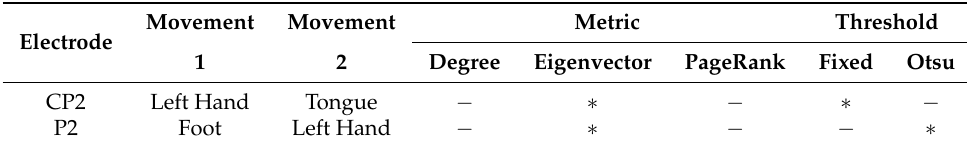
Table 4. p -values < 0.05 for the post hoc Games-Howell test in multilayer of the fixed and Otsu’s threshold on window 3.5–5.5